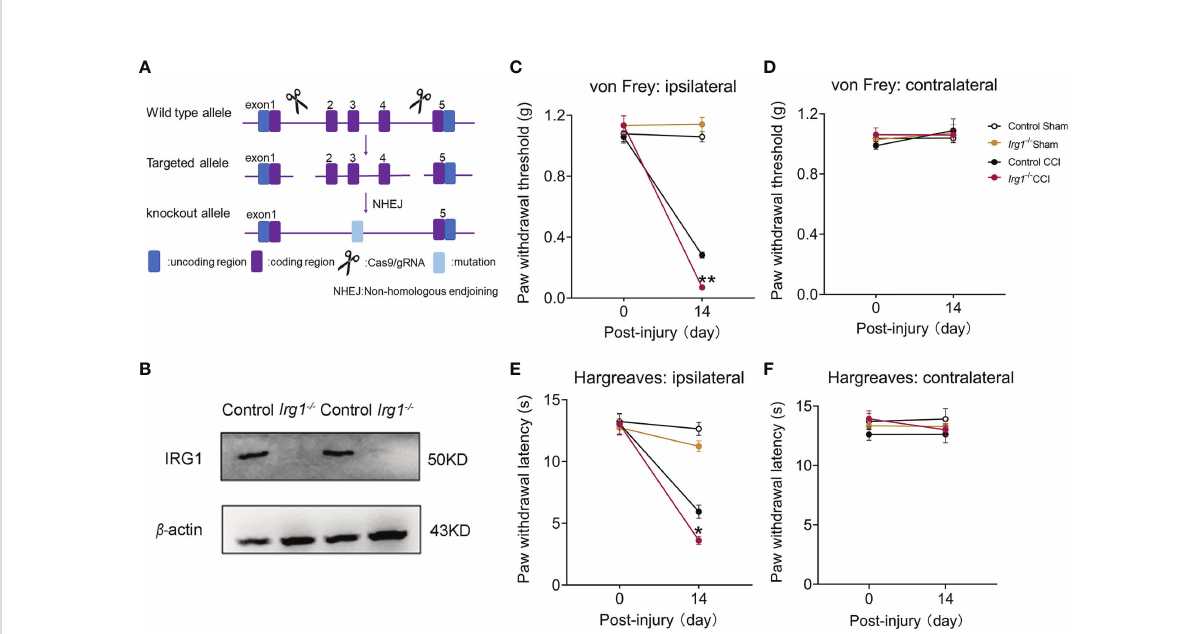
FIGURE 2 The de fi ciency of IRG1 aggravated the pain hypersensitivity after nerve injury. (A) Schematic diagram of constructing Irg1 -/- mice. (B) At 14th days post injury, the protein level of IRG1 in L3-L5 segments of the ipsilateral spinal cords from control CCI and Irg1 -/- CCI mice. (C, D) At 14th days post injury, the PWT of ipsilateral and contralateral hind paw to von Frey test in Sham and CCI mice. (E, F) At 14th days post injury, the PWL of ipsilateral and contralateral hind paw to Hargreaves test in Sham and CCI mice. Data are presented as mean ± SEM. ** p <0.01, * p <0.05 vs. Control CCI, followed by two-way ANOVA with Tukey ’ s multiple comparisons test (n =